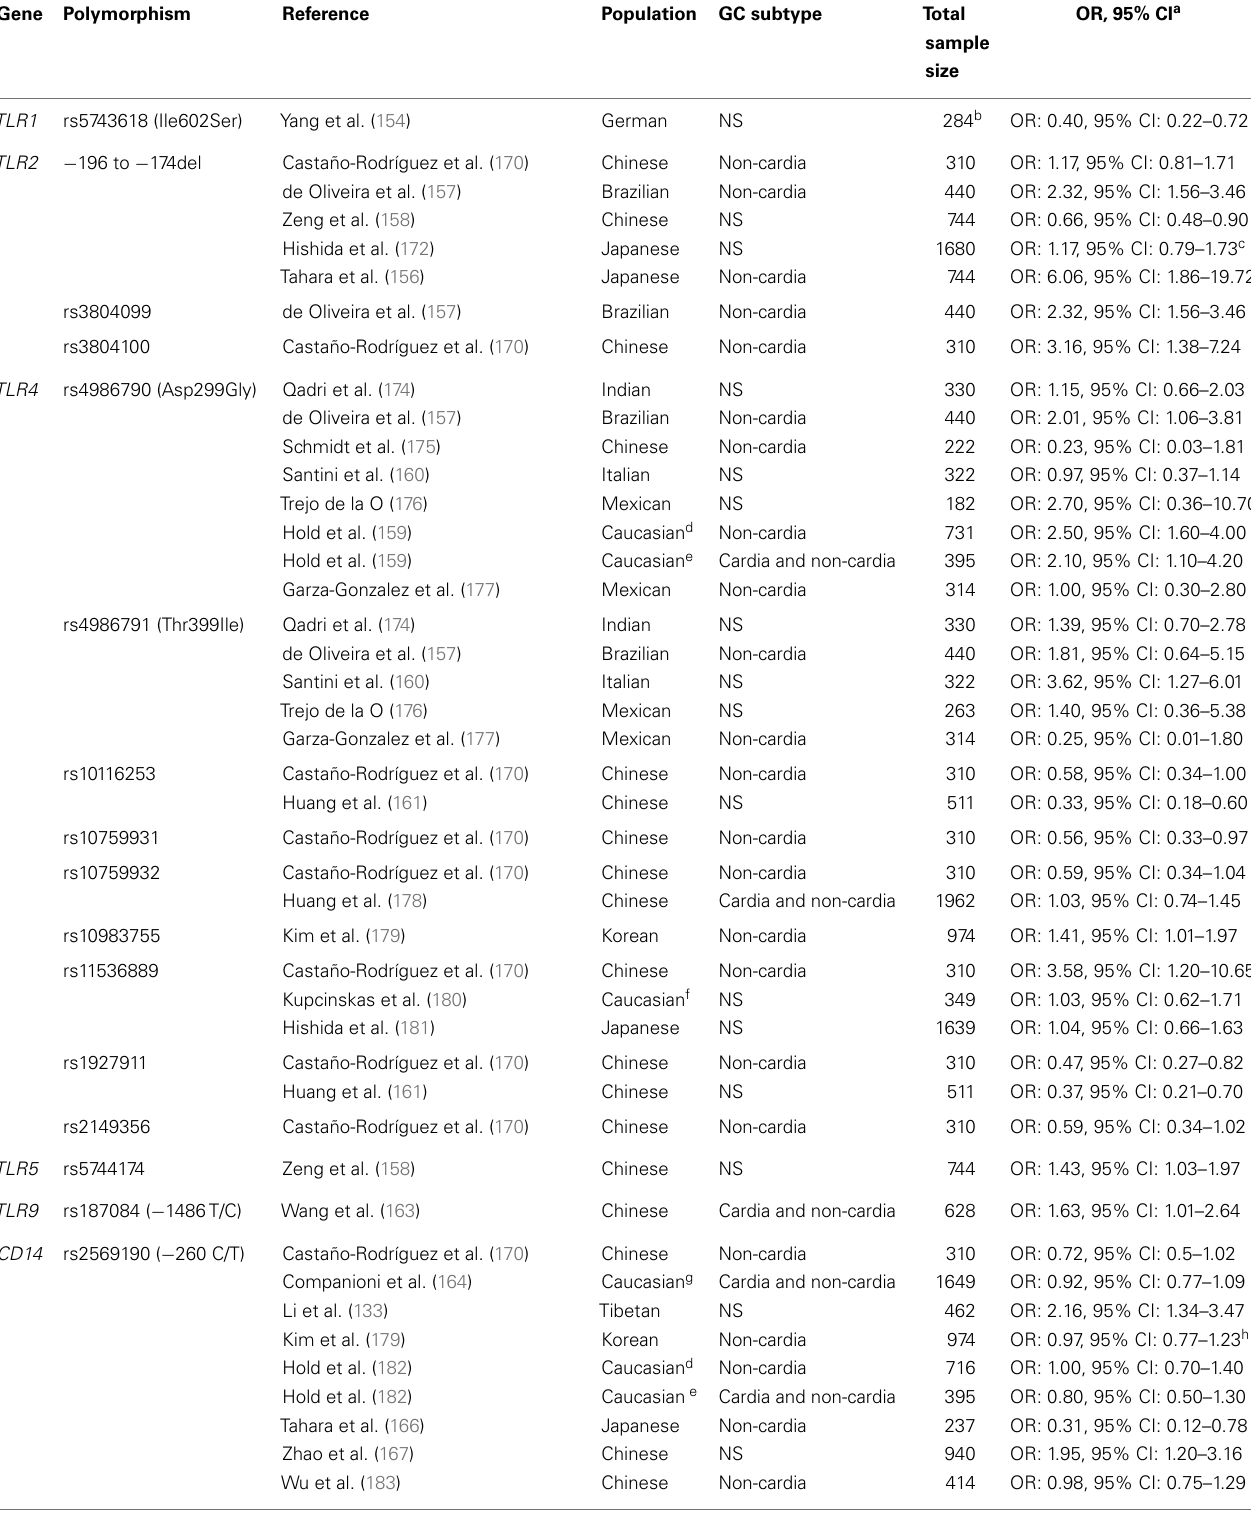
Table 1 | Genetic polymorphisms in theToll-like receptor signalling pathway that have been studied in relation to gastric cancer (170) . Gene